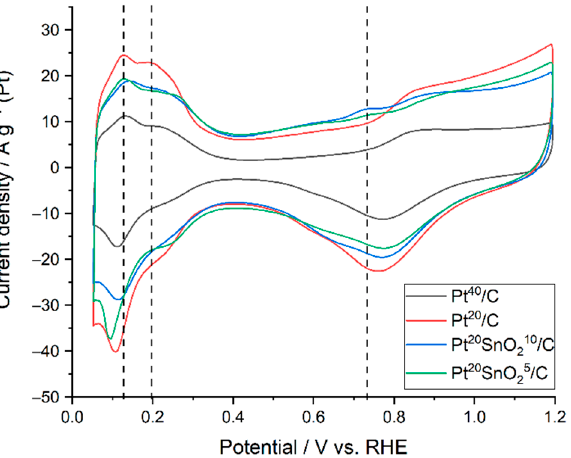
Figure 4. CVs of 40 wt.%-Pt/C (Pt 40 /C), 20 wt.%-Pt/C (Pt 20 /C), 20 wt.%-Pt/5 wt.%-SnO 2 /C (Pt 20 SnO 25 /C), 20 wt.%-Pt/10 wt.%-SnO 2 /C (Pt 20 SnO 210 /C) recorded in the 0.1M HClO 4 solution at 25 °C (scan rate 20 mV s − 1 ).